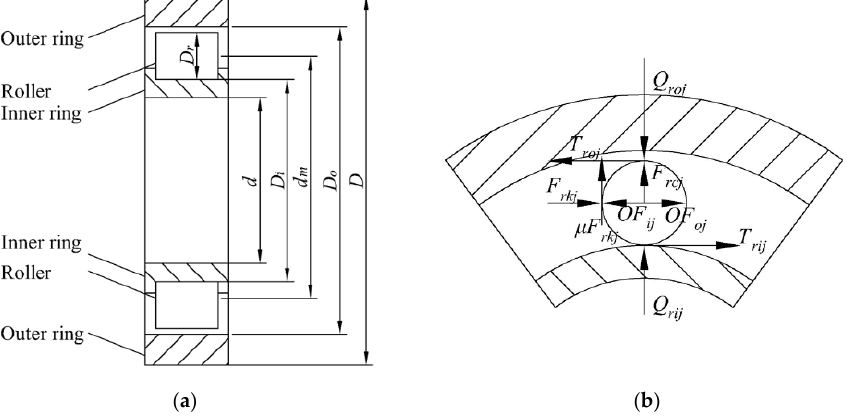
Figure 1. Schematic diagram of roller bearing: ( a ) schematic diagram of bearing structure; ( b ) the forces of a roller.